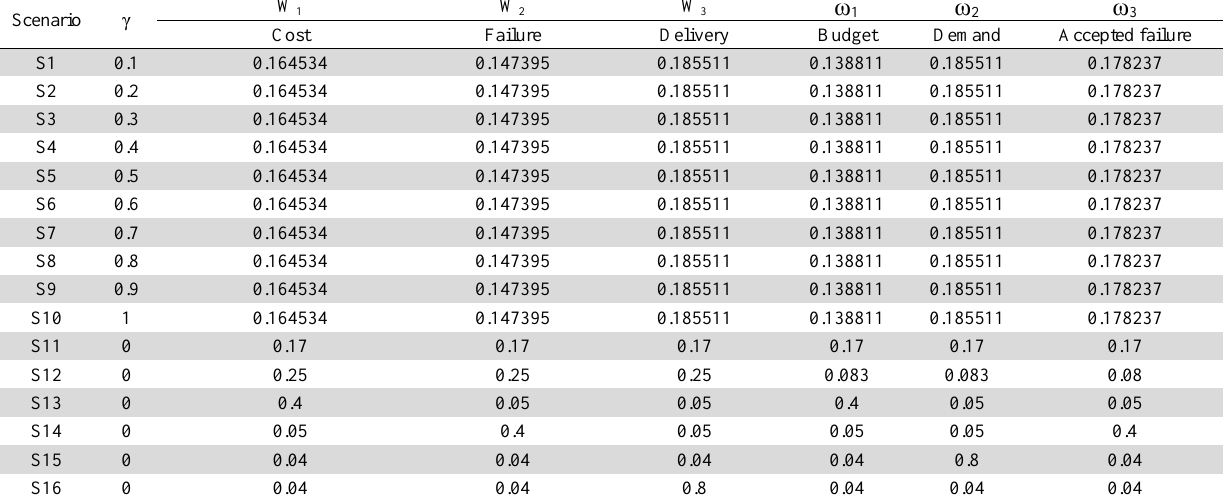
The summary of data for various scenarios calculated using